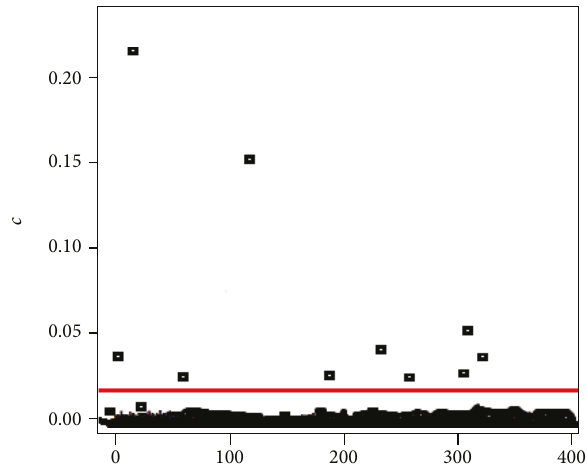
Figure 5: Outliers indicated using Cook ’ s